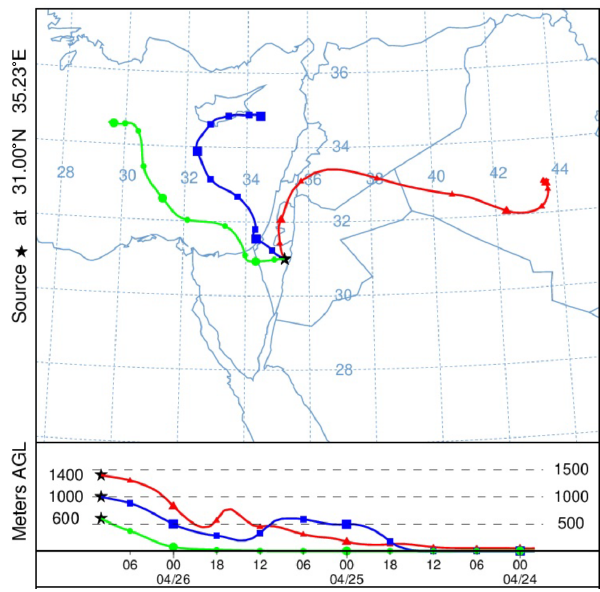
Figure 6. The 60h back trajectory of the air mass reaching the Tzafit Basin on 26 April 2018 at 10:00UTC at heights of 600, 1000 and 1400ma.g.l. (above ground level).